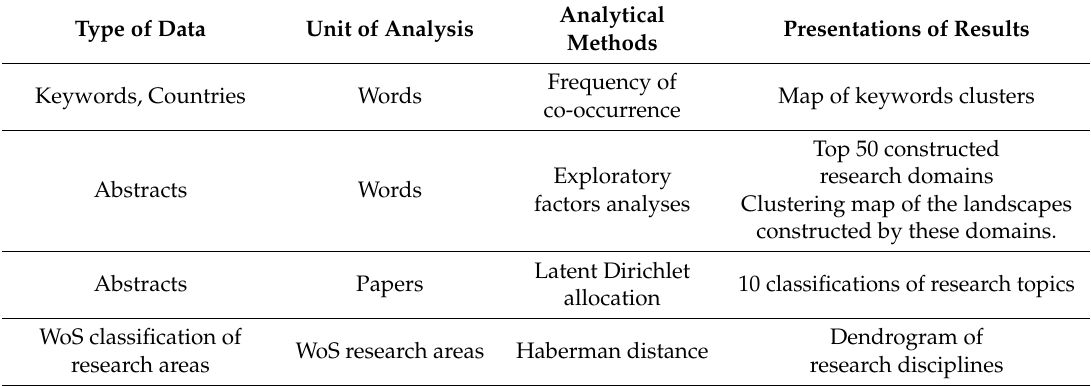
Table 1. Analytical techniques and outcomes of each data type.